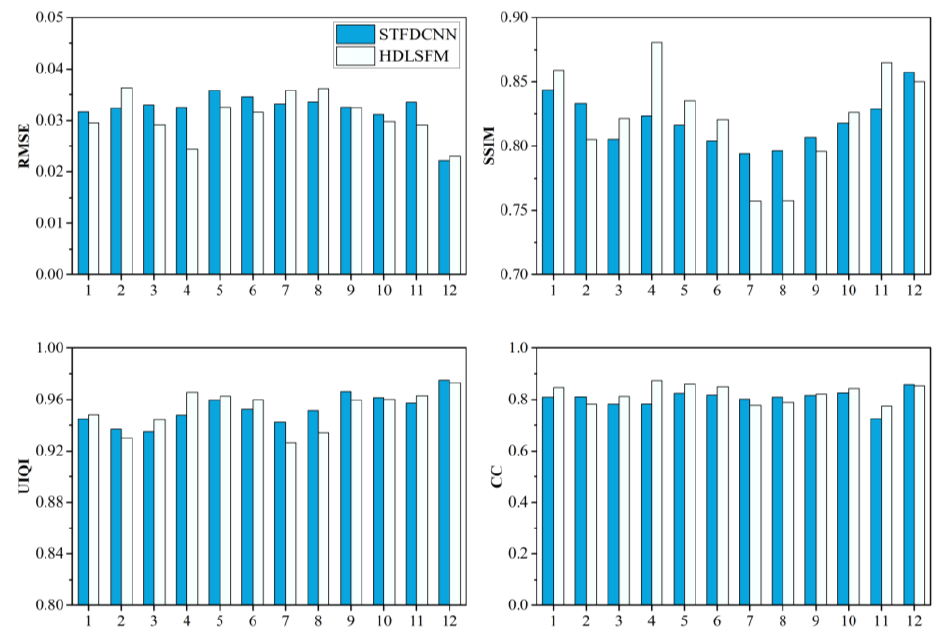
Figure 17. Quantitative assessment of the prediction results of STFDCNN and HDLSFM for the CIA site.